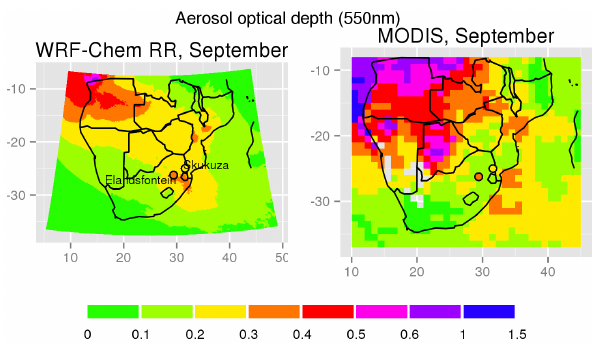
Figure 9. Comparison of modeled AOD with MODIS satellite ob- servations, September 2010.